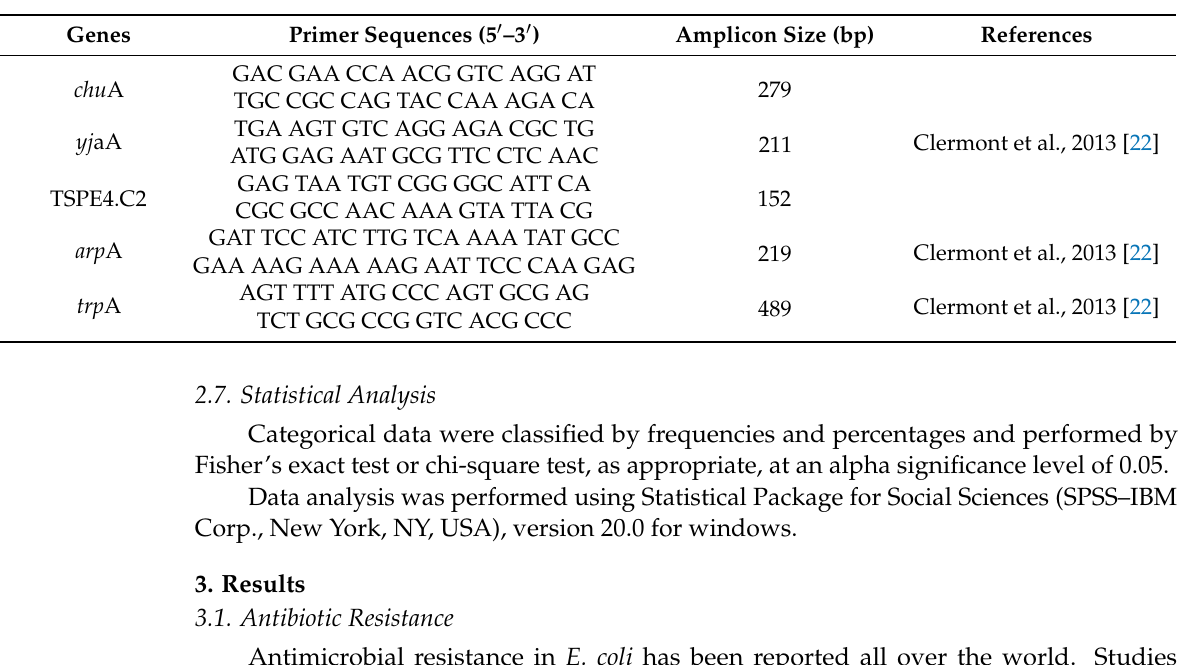
Table 4. Genes researched for phylogenetic